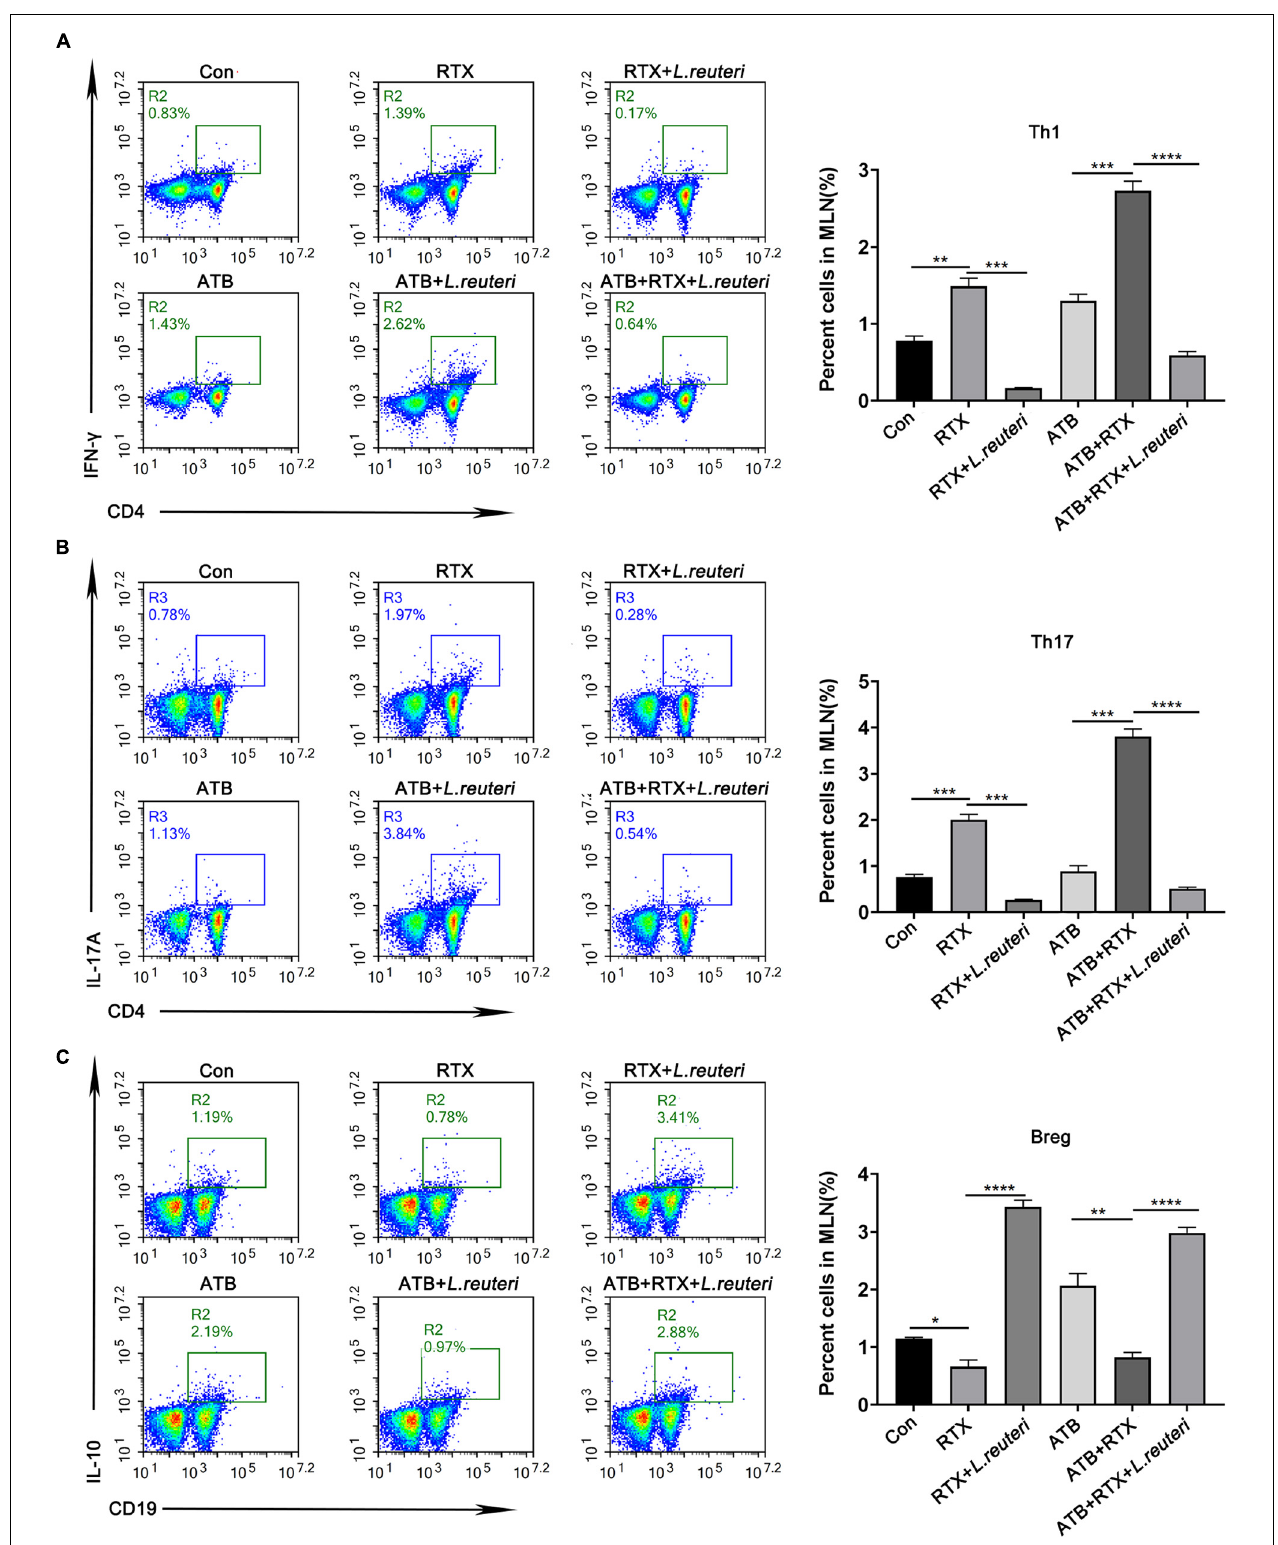
FIGURE 7 | Lactobacillus reuteri supplementation alleviates Th cell imbalance induced by RTX and inhibits Th1 and Th17 immune responses. (A) Th1 cells, (B) Th17 cells, and (C) Breg cells in MLN cells. Data are expressed as the mean ± SEM. p < 0.05, ** p < 0.01, *** p < 0.001, **** P < 0.0001.